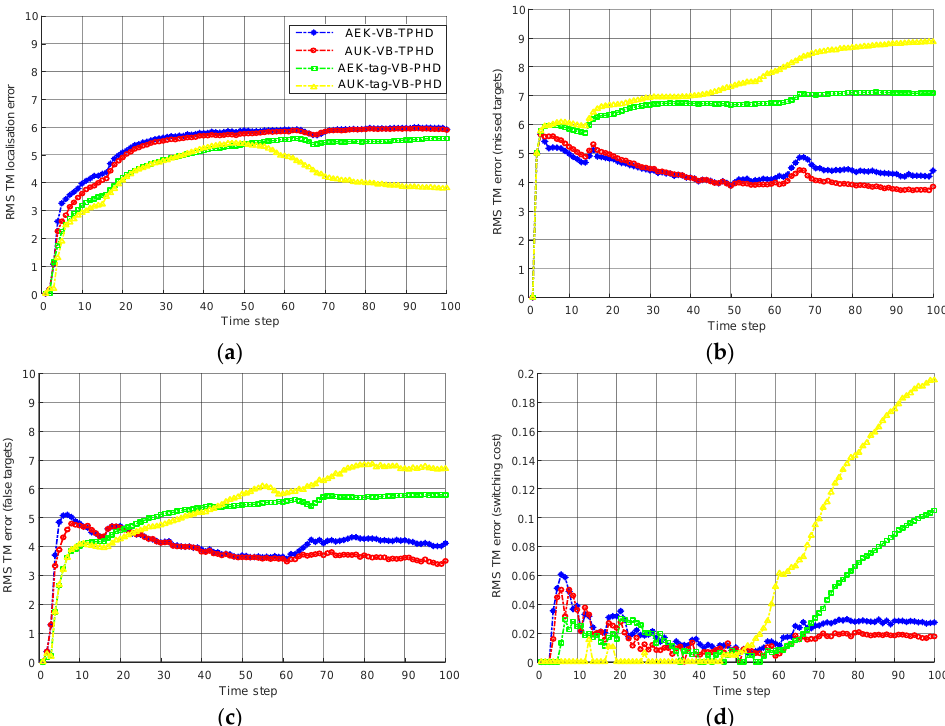
Table 4. The RMS TM error of the AEK-VB-TPHD and AUK-VB-TPHD filters. Figure 9. Comparison of VB-TPHD and VB-PHD using EK and UK two nonlinear implementation forms under the decomposition of RMS TM metric with time varying measurement noise. ( a ) RMS TM error of localization. ( b ) RMS TM error of false targets. ( c ) RMS TM error of missed targets. ( d ) RMS TM error of switching cost ( L = 5).